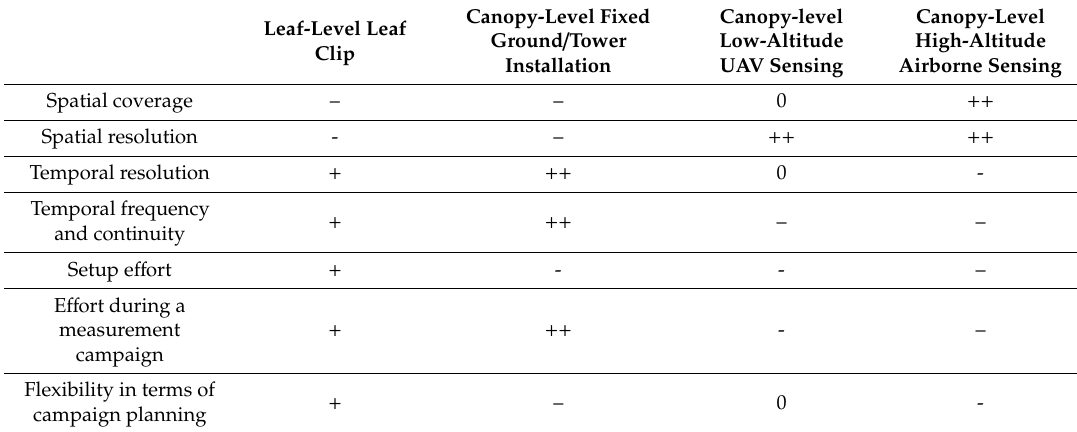
Table 1. Summary table of F measurements at multiple levels and scales with small and high advantages ( + , ++ ), neutral (no advantage or disadvantage) (0), and small and high disadvantages (-, –) for each